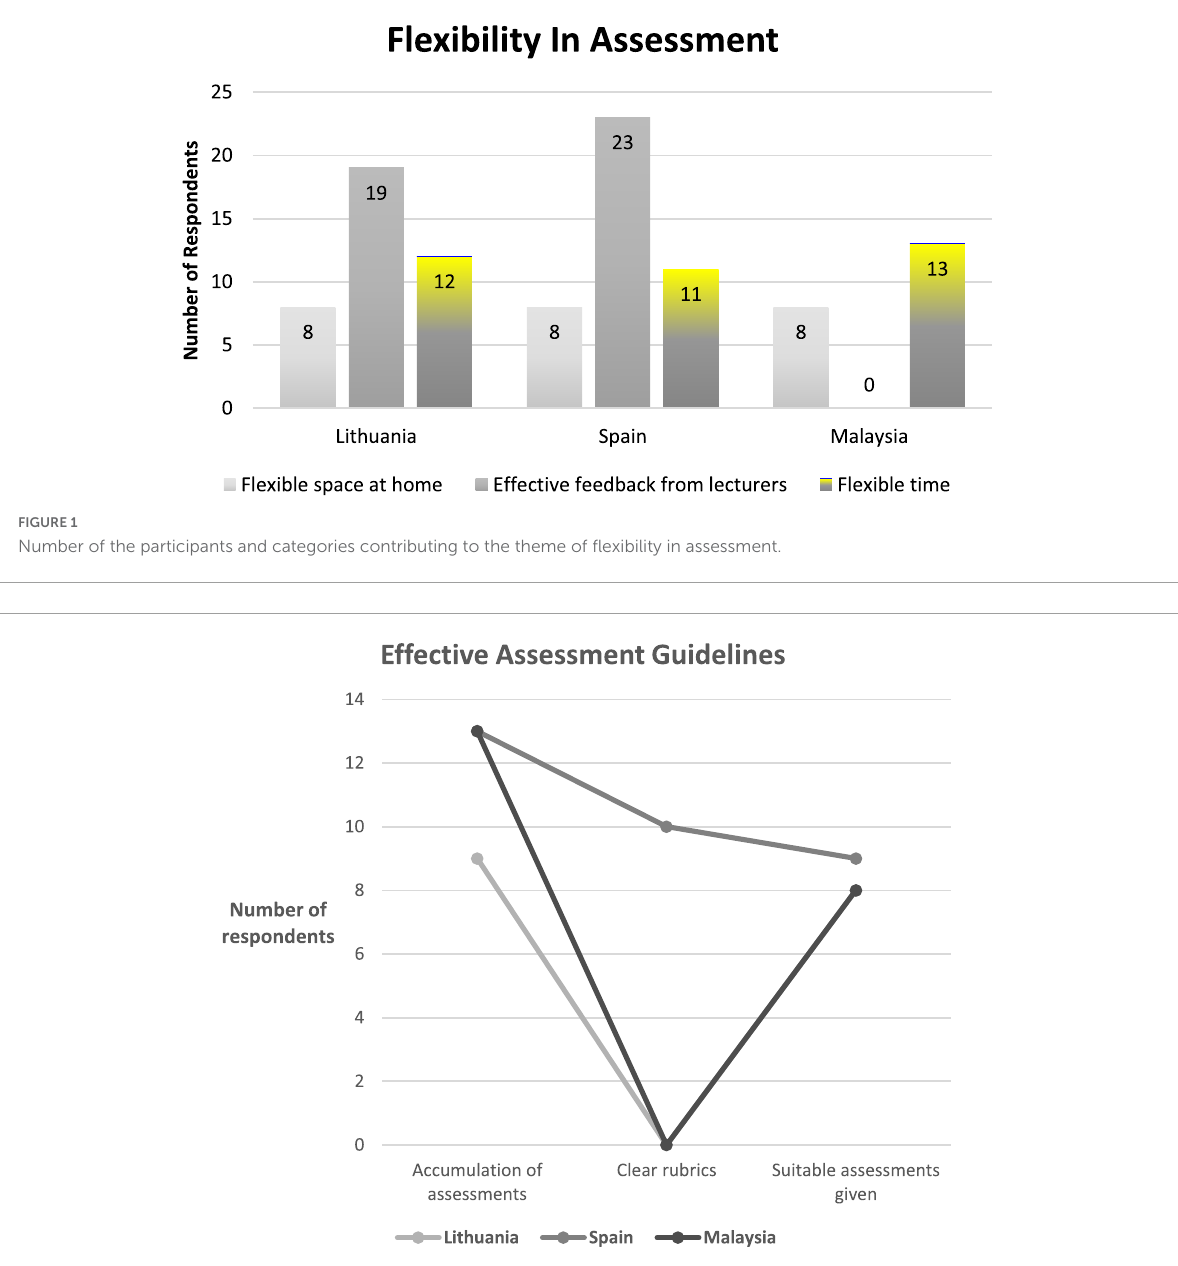
FIGURE2 Number of participants and categories contributing to the theme of effective assessment